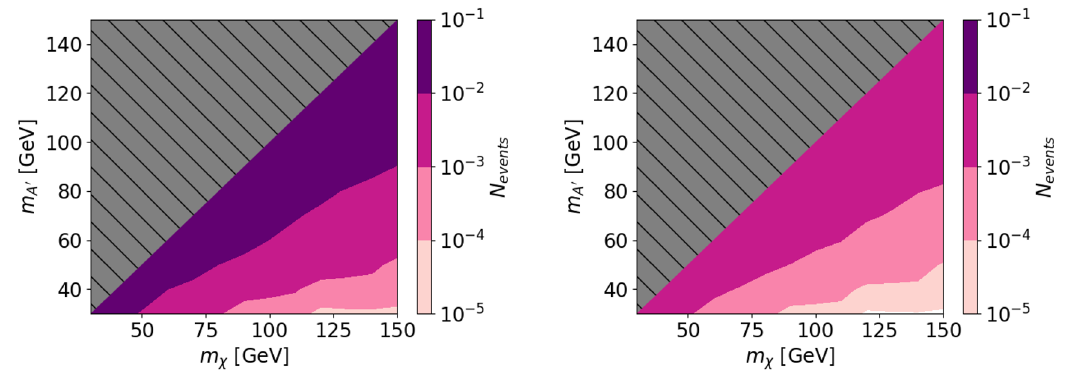
Figure 13. Expected number of antihelium events seen by GAPS during the 105-day (cid:13)ight period, assuming the most optimistic MAX (left) and conservative MED (right) propagation model.